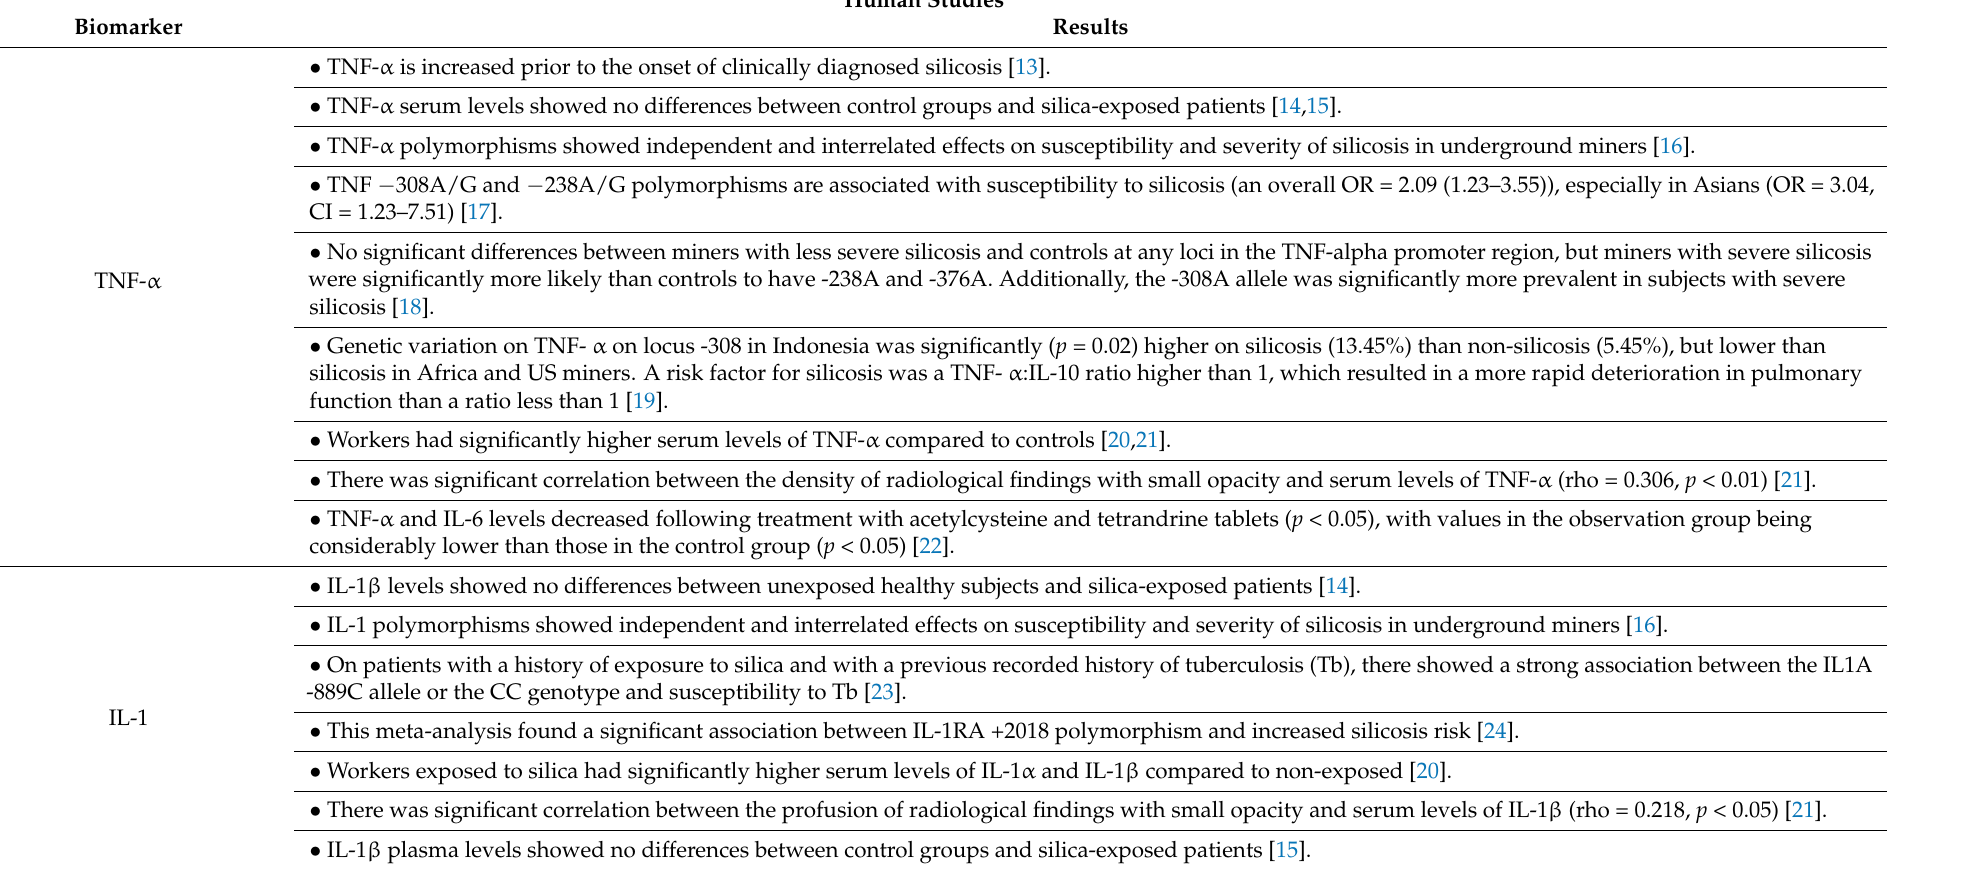
Table 1. Extraction table of the 33 articles included in the narrative review (TNF—Tumour necrosis factor, OR- Odds ratio, CI—Confidence interval, IL—Interleukin, CC16—Clara cell 16, BALF—Broncho-alveolar lavage fluid, FEV1—Forced expiratory volume in 1 s, VC—Vital capacity, ELISA—Enzyme- linked immunosorbent assay, KL-6—Krebs von den Lungen 6, SP-D—Serum surfactant protein D, MMP—Matrix metalloproteinase, MUC5B — Mucin 5B